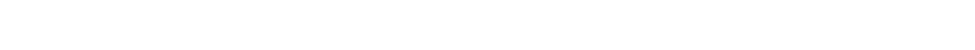
FIGURE 3 | Effects of (A) temperature and time and (B) glucose and cellobiose concentration on cellulase re-adsorption